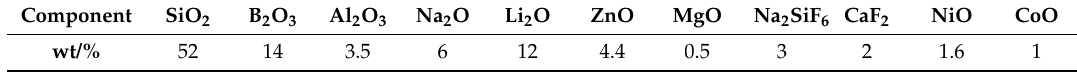
Figure 1. Processing of sintering enamel coating on the grey cast iron. Table 1. Chemical composition of the raw materials used for